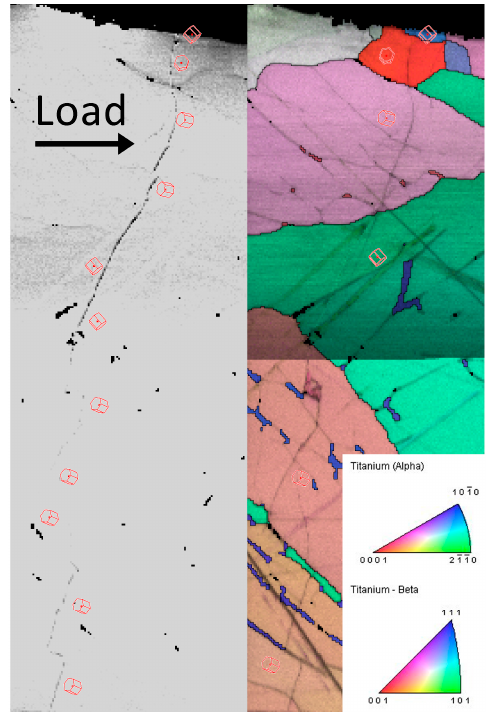
Figure 10. SEM and EBSD micrograph of a fatigue crack in a circular notched specimen.